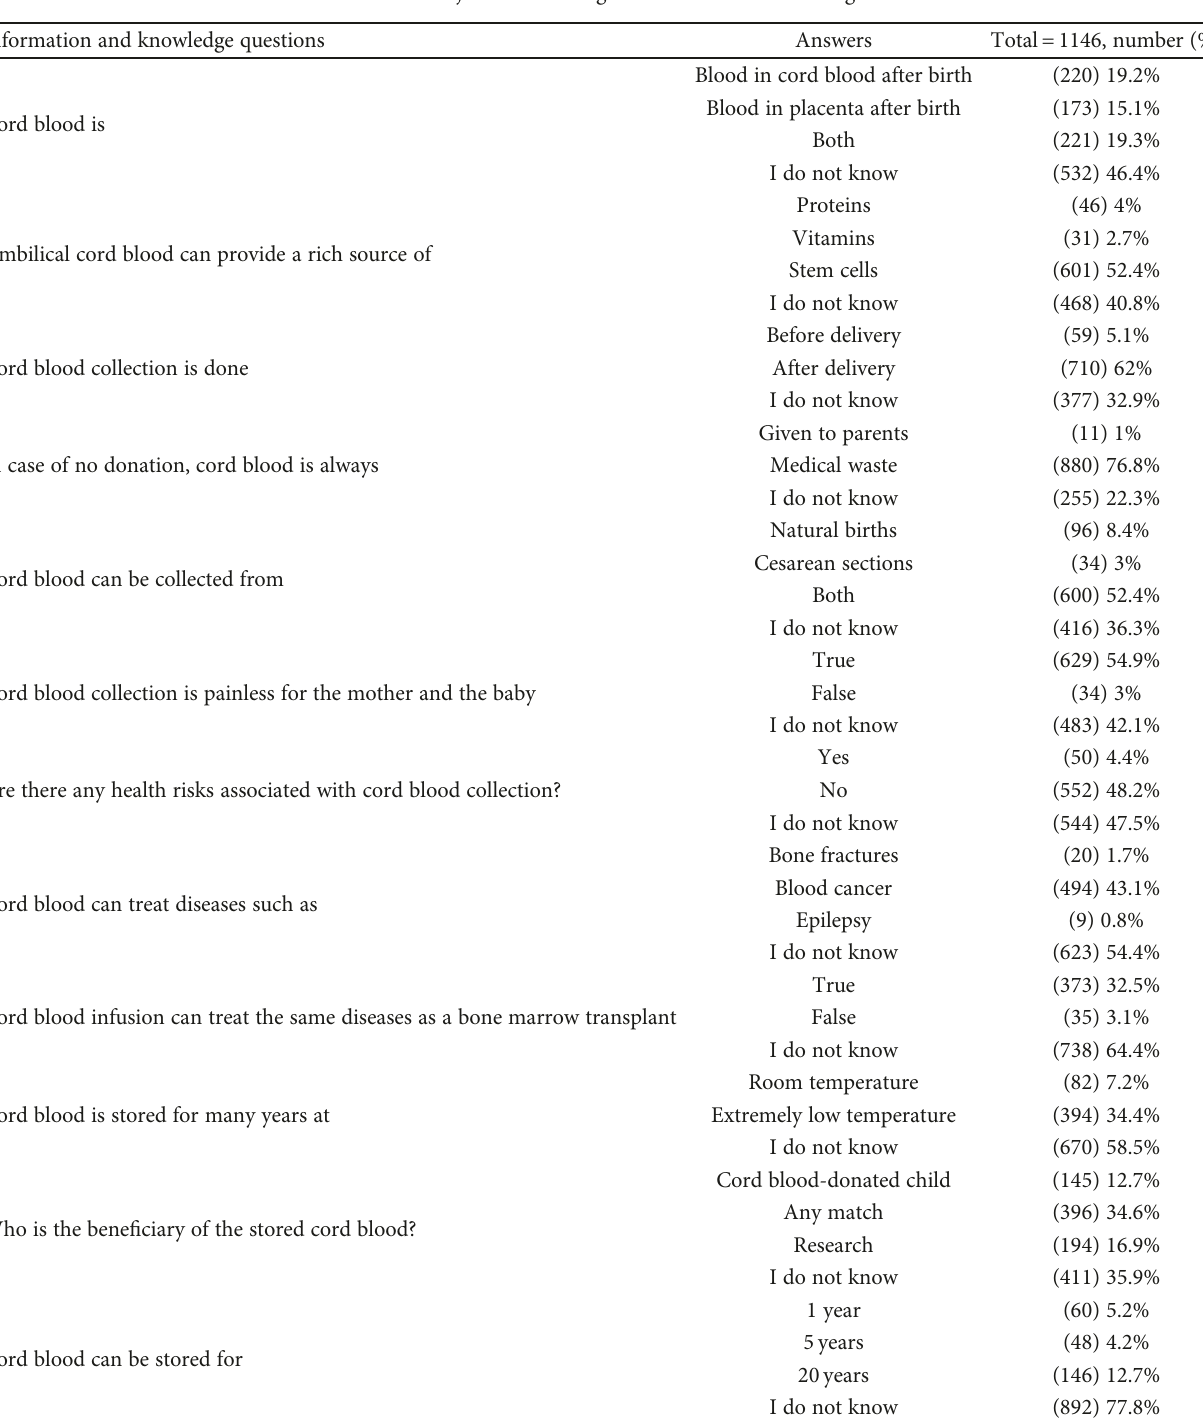
Table 3: Objective knowledge about cord blood banking.